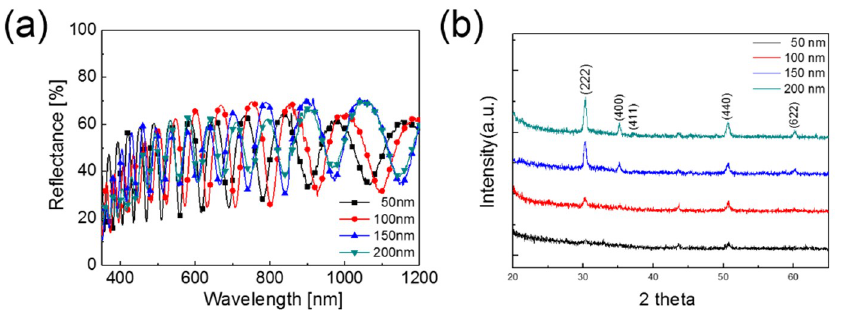
Figure 3. ( a ) Reflectance ITO films sputtered on SiO 2 coated invar substrate with increasing film thickness. ( b ) XRD plots of the ITO films sputtered on SiO 2 coated invar substrate at room temperature